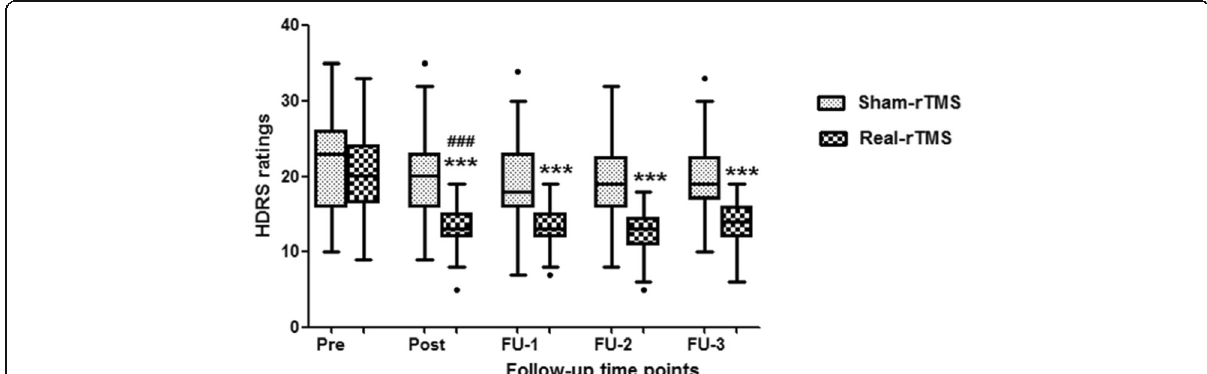
Fig. 2 : Effect of rTMS on pain related depression in FMS. Depression assessed by Hamilton depression rating scale (HRDS) in Sham ( n = 41) and Real-rTMS ( n = 45) group at each time points;pre, post and follow up (FU-1 = 15 days, FU-2 = 3 months and FU-3 = 6 months post-rTMS). Hash (#) symbol indicates within group p value. Asterisk (*) symbol indicates p value between Sham-rTMS and Real-rTMS group. * p or # p < 0.05; ** p or ## p < 0.01; *** p or ### p <